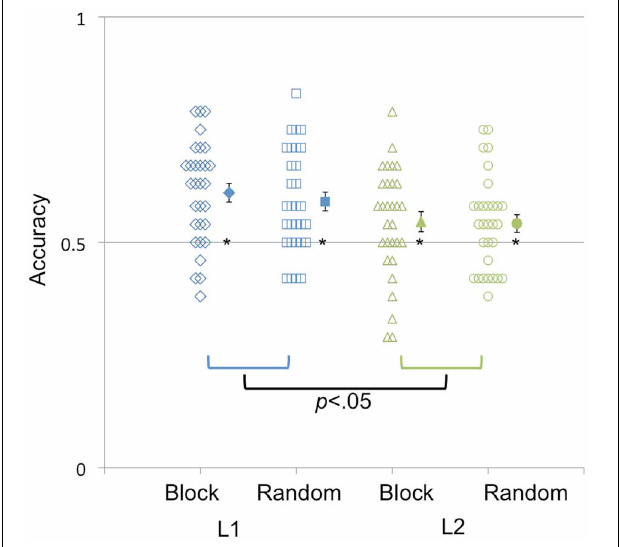
FIGURE 1 | Accuracy (percentage correct) in identifying whether silent video clips were from the same or different languages in both Random and Blocked speaker orders. The y -axis represents mean accuracy; the x -axis represents whether the adults had learned English before age 2 (L1) or after the age of 2 years (L2). Filled-in symbols represent the group means. Error bars represent the standard error of the mean. ∗ p < 0 .